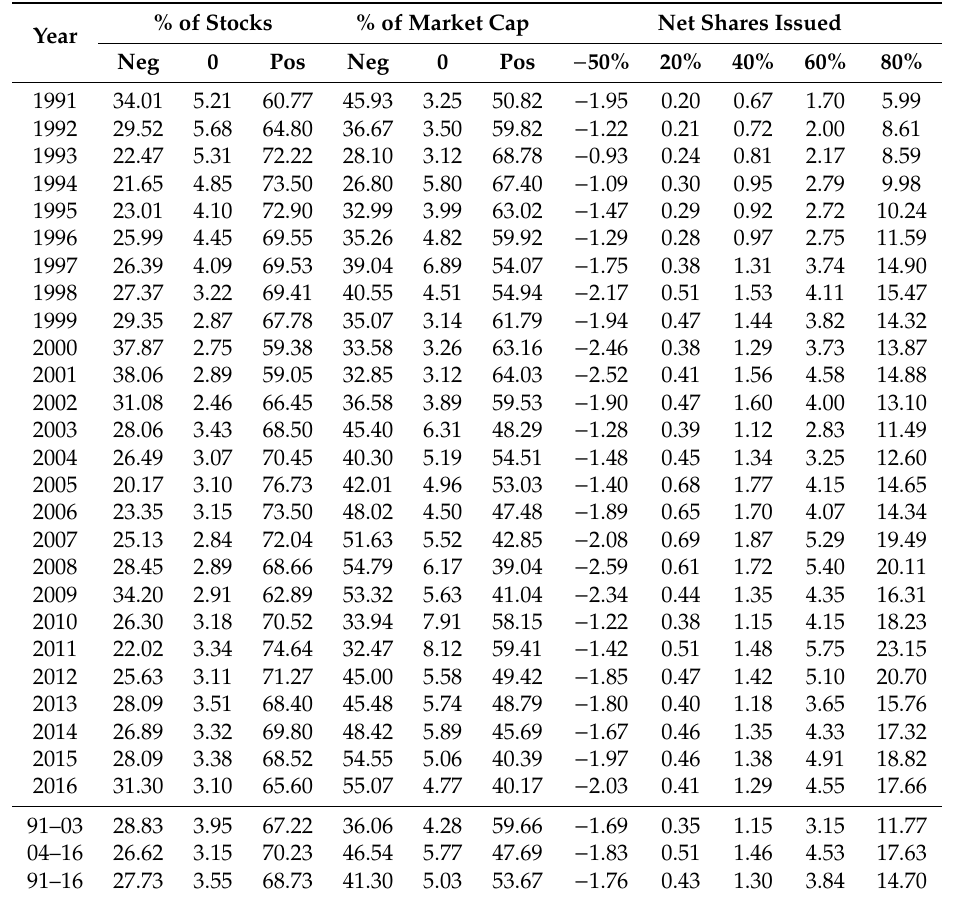
Table 9. Net Shares Issues—North America 1991–2016. For North America, net share issues (the number of shares issued minus repurchased) are computed for all stocks on an annual basis. Columns 2–4, % of Stocks, list the fraction of all stocks that are net repurchasers (Neg), net issuers (Pos) and that have zero net issues (0). Columns 5–7, % of Market Cap, list the percent of total market capitalization of net repurchasers, net issuers, and firms that do not repurchase or issue. The last five columns list the median percent share repurchase ( − 50%), as well as the quintile breakpoints for issues. The last three rows provide averages over the full sample, ‘91–16’, and over two subperiods, ‘91–03’ and